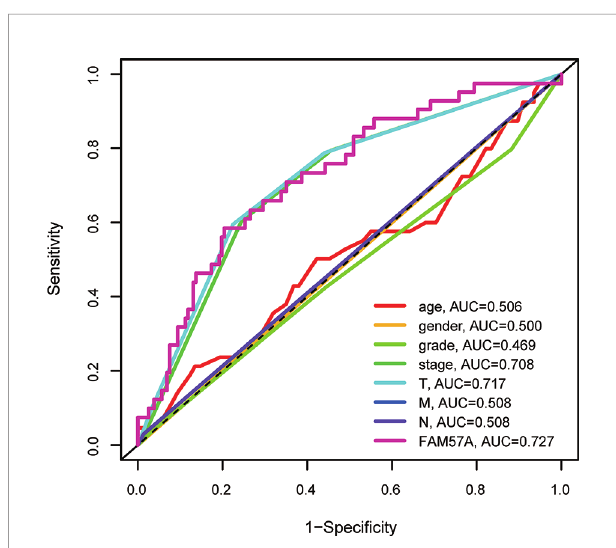
FIGURE 6 | AUCs of prognostic predictors (including grade, gender, age, clinical stage, T stage, M stage, N stage and FAM57A expression). AUC, area under the curve.